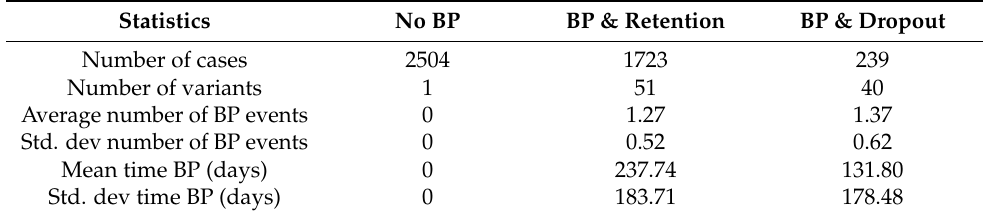
Table 4. Statistics for BPPM